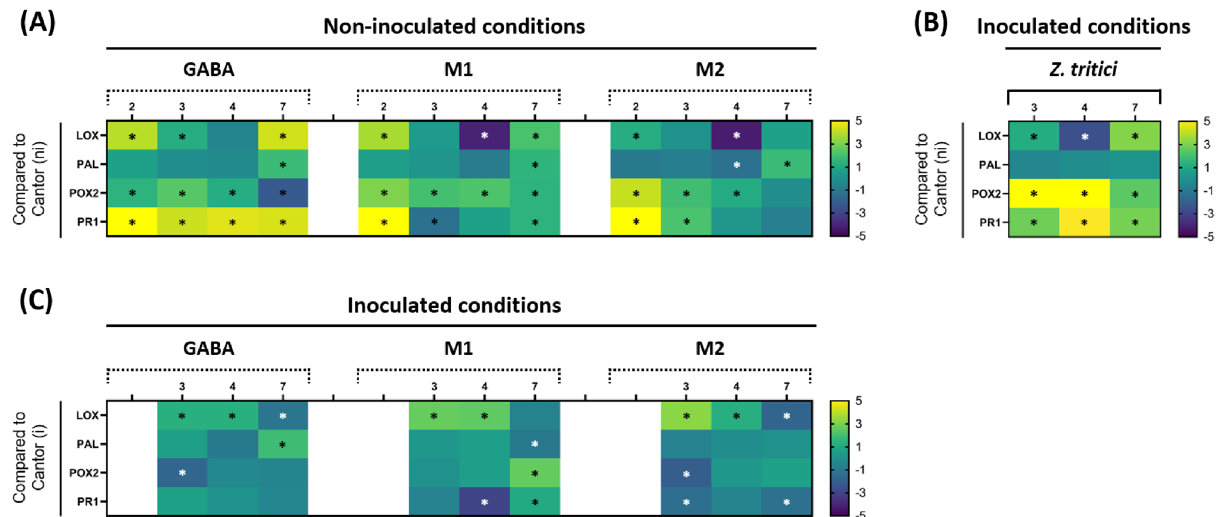
Figure 5. Relative expression of four selected defense-related genes in wheat leaves (cultivar Alixan) treated or not with γ- aminobutyric acid GABA, M1 and M2 and inoculated or not with Zymoseptoria tritici (strain T02596). ( A ) non-infectious conditions (ni) where GABA, M1 and M2-treated and non-inoculated plants are compared to Cantor-treated and non-inoculated plants; ( B ) Cantor-treated and inoculated plants compared to Cantor-treated and non-inoculated control plants; ( C ) GABA-, M-1 and M2-treated and inoculated plants compared to Cantor-treated and inoculated control plants. The data are resulting from two independent experiments, with three biological replicates and two technical replicates (six replicates) each. Values of relative gene expression were converted to Log 2 and represented in the form of a heatmap. Over-expression is highlighted with shades of green to yellow, while down-expression is presented with shades of purple to blue. The genes were considered significantly down-regulated (white asterisks) or up-regulated (black asterisks) compared to the corresponding controls when changes in their expression were < 0.5 × or > 2 x, respectively. The numbers on the heatmap indicate days post-treatment